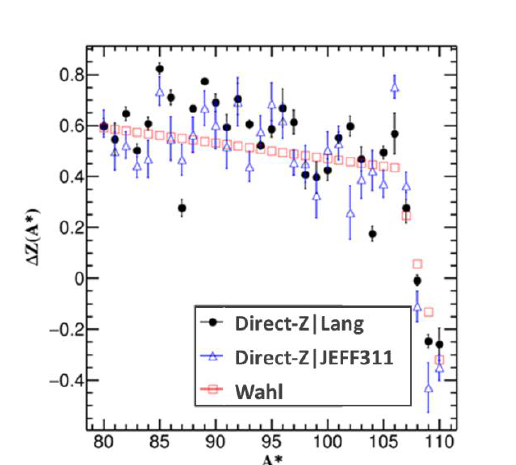
Fig. 13. The evolution of the pre-neutron emission charge polarization, in black the data determined via the adjustment based on Lang data, in blue the data determined via the adjustment based on JEFF-3.1.1 data and in red the data of Wahl’s systematics parameterization.